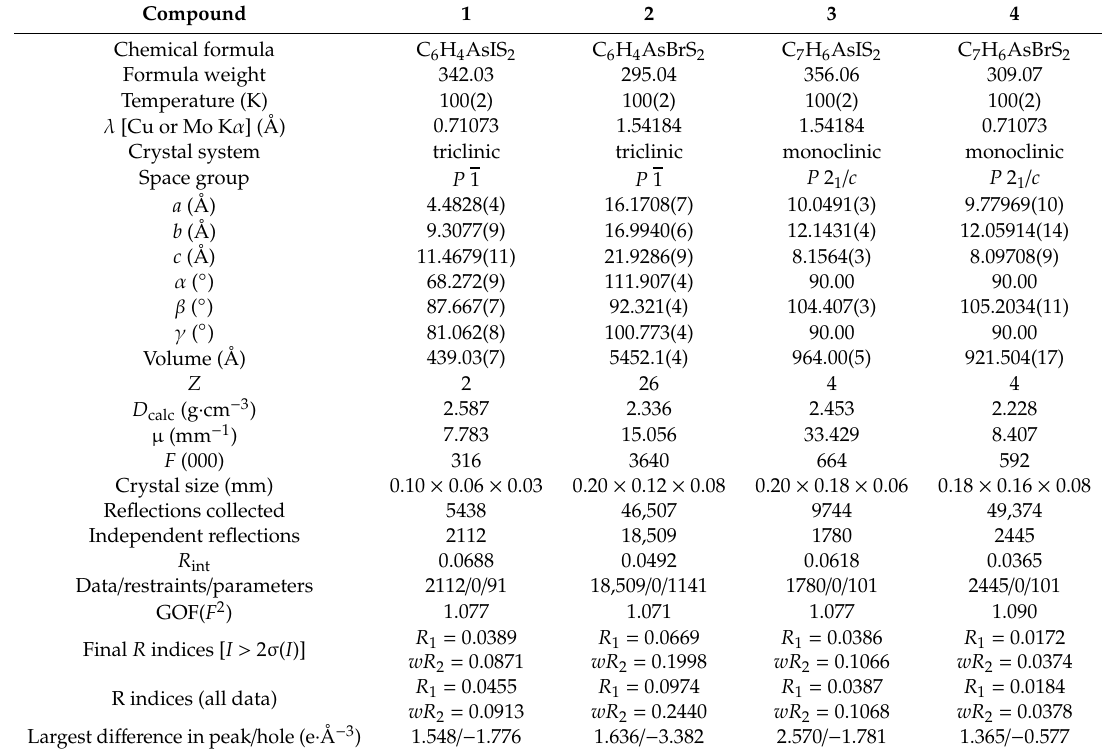
Figure 3. Fragment of the crystal structure of 1 showing some intermolecular interactions between AsI(PhS 2 ) molecules. Table 2. Crystallographic data and structure refinement parameters of the compounds 1 − 4